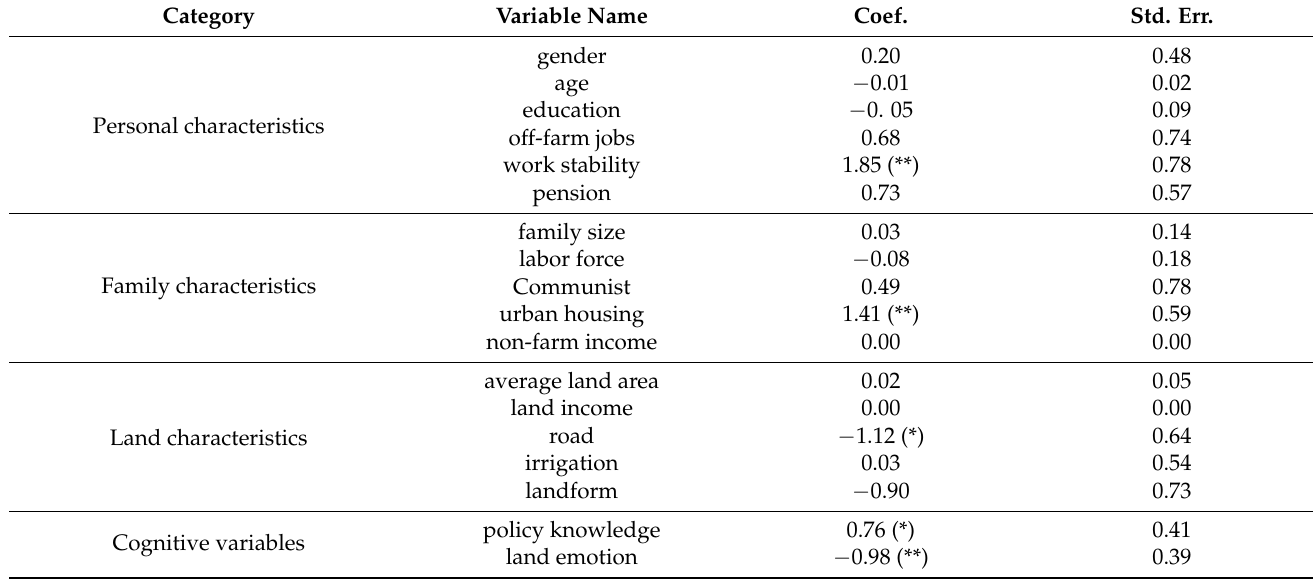
Table 4. Probit selection estimates in Heckman sample selection model regression